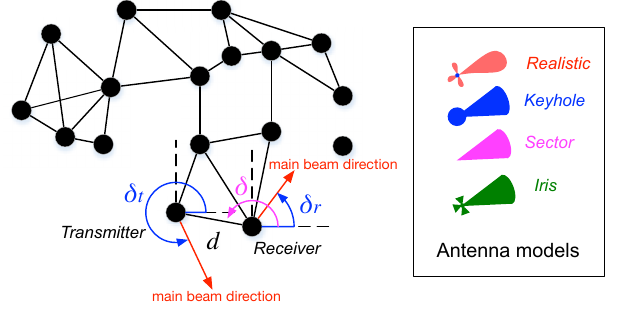
Figure 7. Relative positions of a transmitter and a